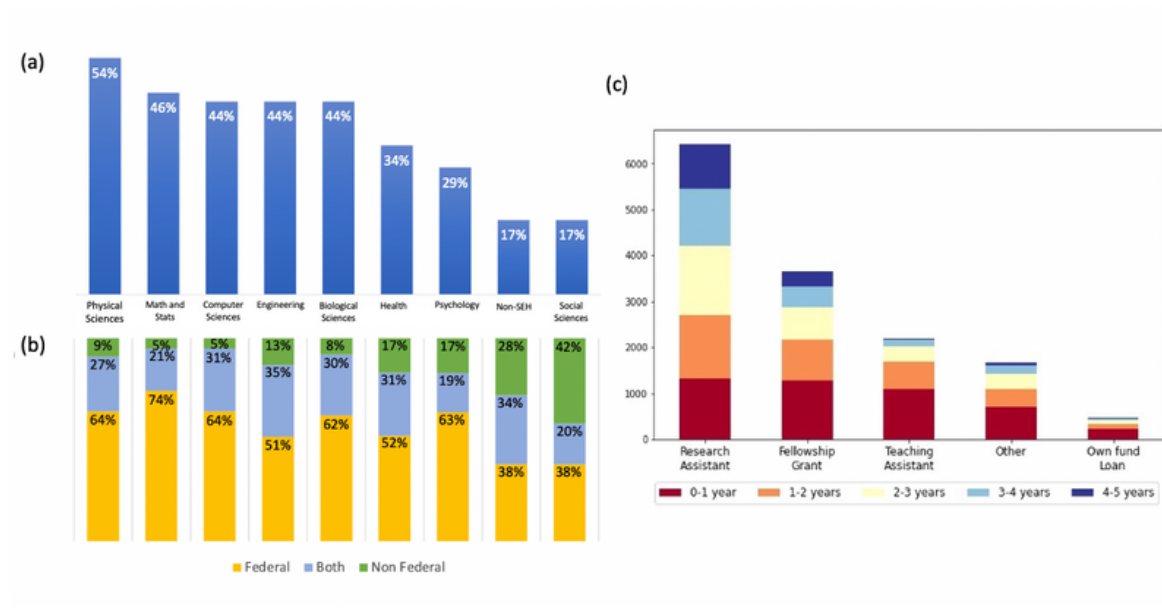
Figure 4. SED-UMETRICS linked data for graduate cohort FY 2014–2017. (a) Match rate by doctoral field of study. (b) Distribution (percent) of funding type by field of study. Funding type is classified into federal source only, nonfederal source only, and funded by both federal and nonfederal sources. (c) Distribution (count) of funding duration by the primary source of financial support during graduate school reported in SED. SED = Survey of Earned